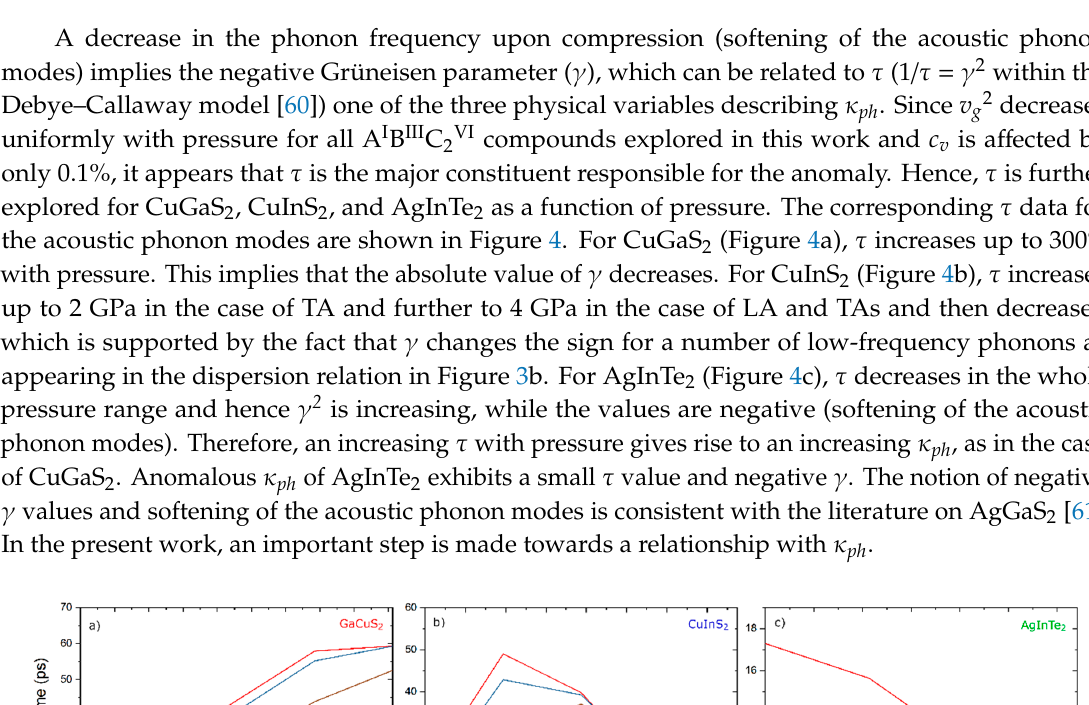
Figure 5. Volumetric thermal expansion coefficient at ambient pressure for CuGaS 2 , CuInS 2 , CuInTe 2 , and AgInTe 2 . 4. Conclusions The thermal conductivity of CuGaS 2 , CuInS 2 , CuInTe 2 , and AgInTe 2 A I B III C 2VI chalcopyrites exhibits a different behavior under pressure, ranging from increasing (CuGaS 2 ), as for most compounds, alternating (increasing and decreasing for CuInS 2 ), and to decreasing, as in the case for CuInTe 2 and AgInTe 2 , which is anomalous. This can be understood based on the phonon dispersion curves. Softening of the acoustic phonon modes occurs for these anomalous chalcopyrites. This leads to the negative Grüneisen parameter and negative volumetric thermal expansion coefficient. The